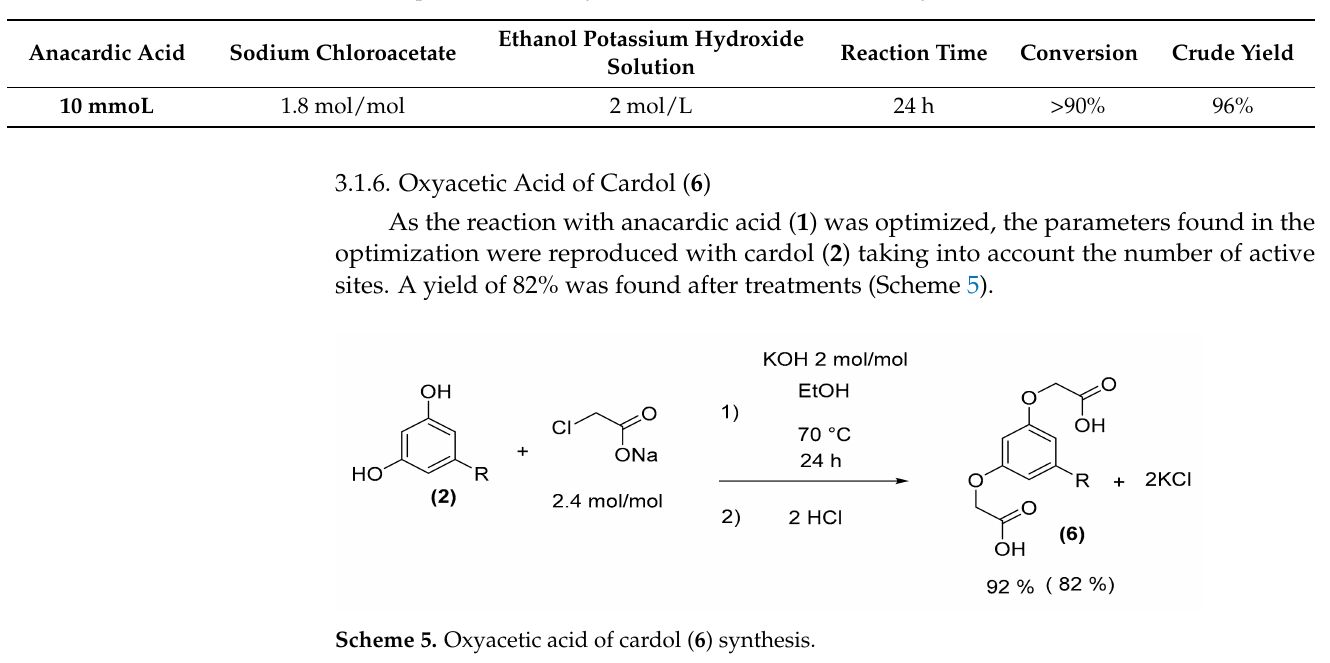
Table 7. Optimization of oxyacetic acid of anacardic acid ( 5 )